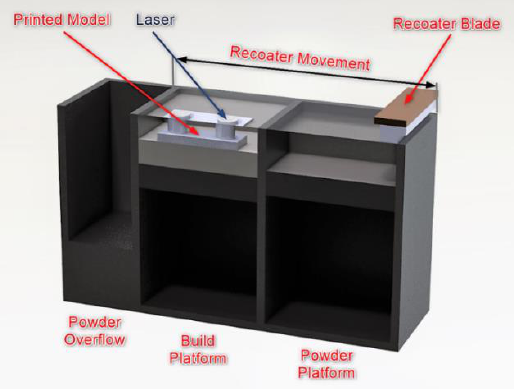
Figure 1. Schematic representation of the Concept Laser M2 Laser Cusing ® system.